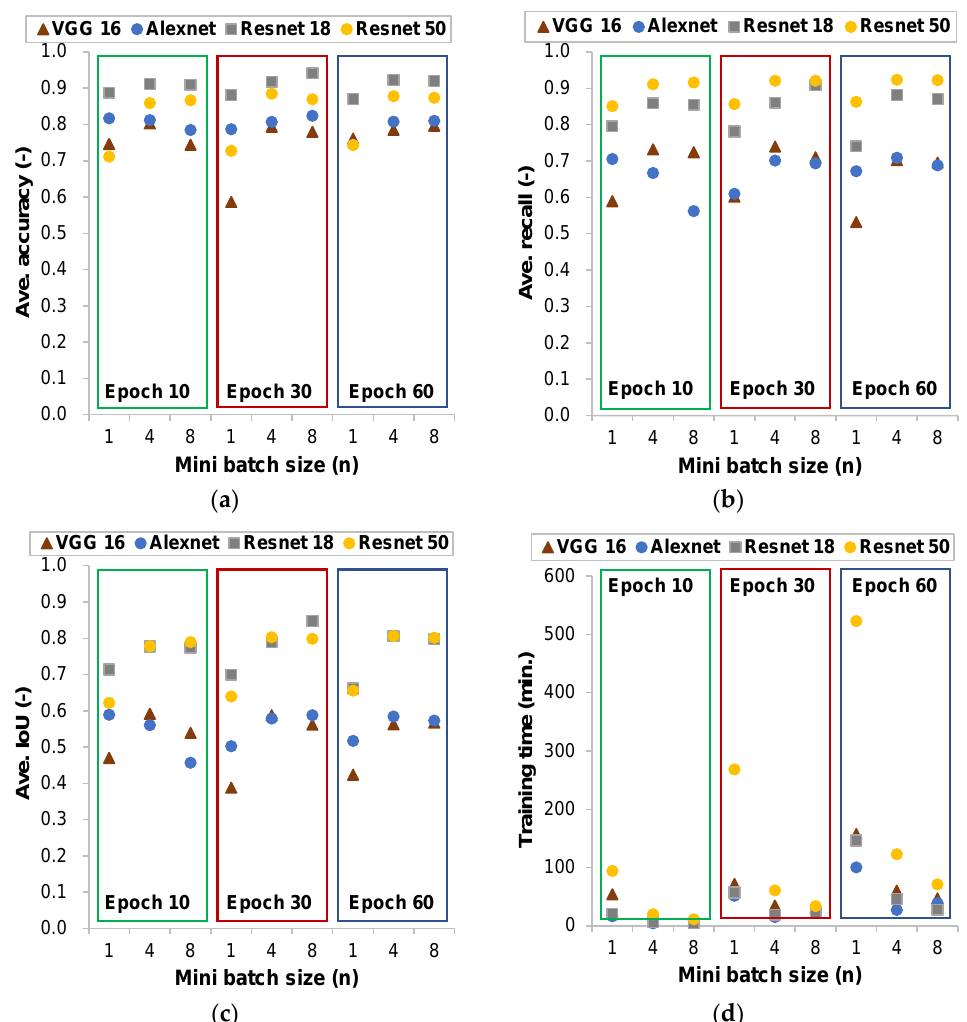
Figure 3. Evaluation of CNN models based on the evaluation metrics: averaged values of accuracy ( a ), recall ( b ), and IoU ( c ) for testing datasets and ( d ) training time for dataset.